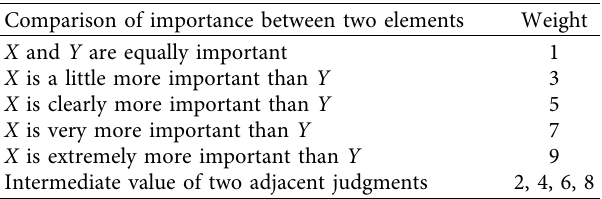
Table 2: Definition diagram of judgment matrix. Comparison of importance between two